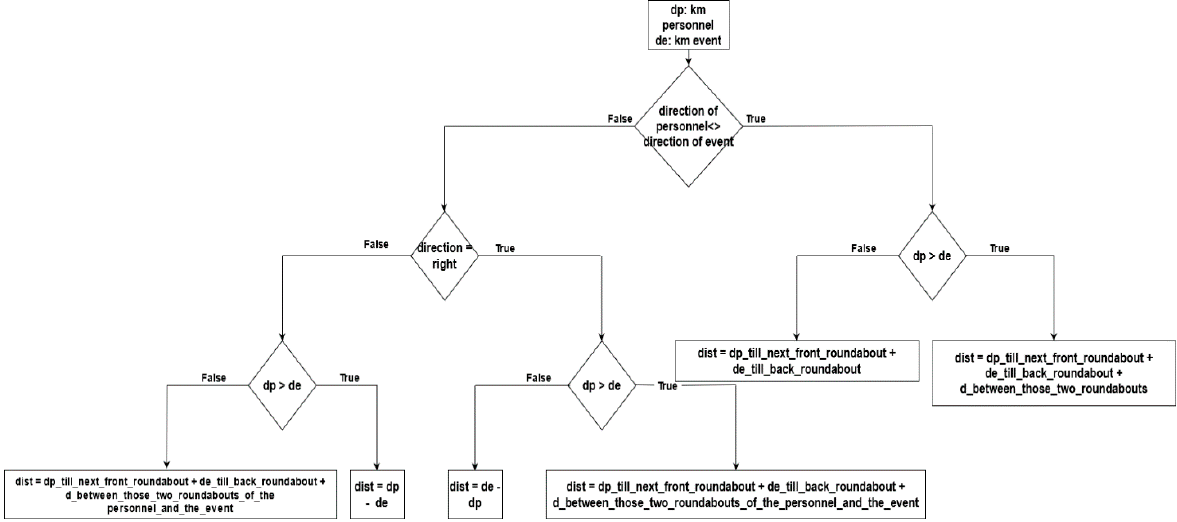
Figure 3. RMS distance algorithm flowchart and